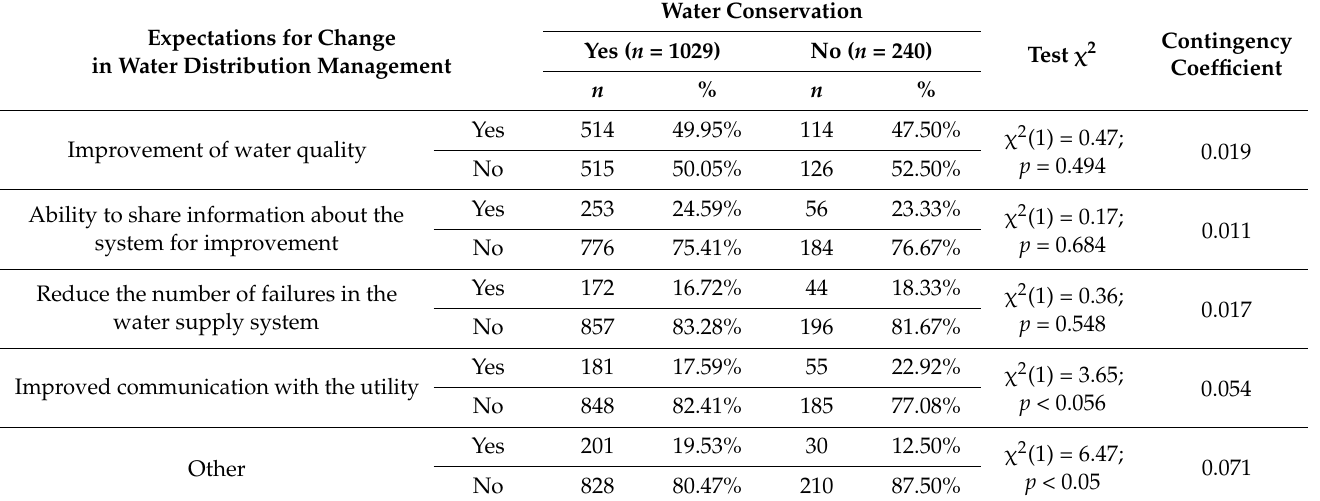
Table 3. The relationship between respondents’ water conservation and their expectations of changes in water distribution